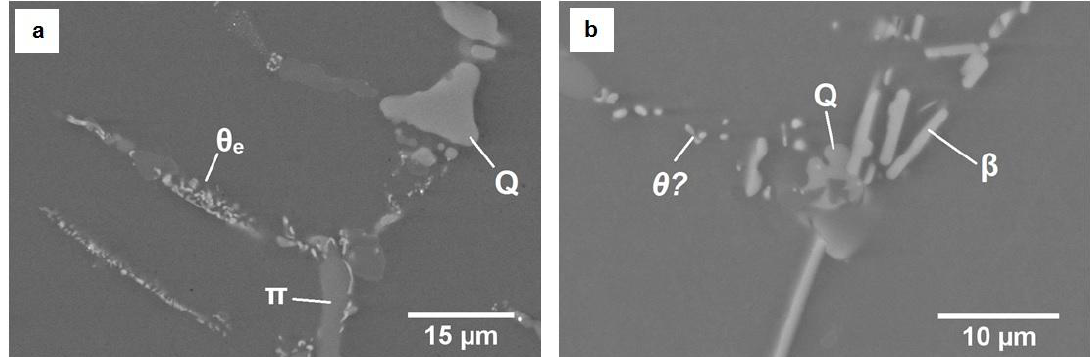
Figure 6 . SEM images of A354 samples subjected to double stage solution treatment: 495 °C—6 h, Figure 6. SEM images of A354 samples subjected to double stage solution treatment: 495 ◦ C—6 h, then 515 °C—2 h ( a ), and 530 °C—8 h ( b ), which is readapted from Reference [21]. then 515 ◦ C—2 h ( a ), and 530 ◦ C—8 h ( b ), which is readapted from Reference